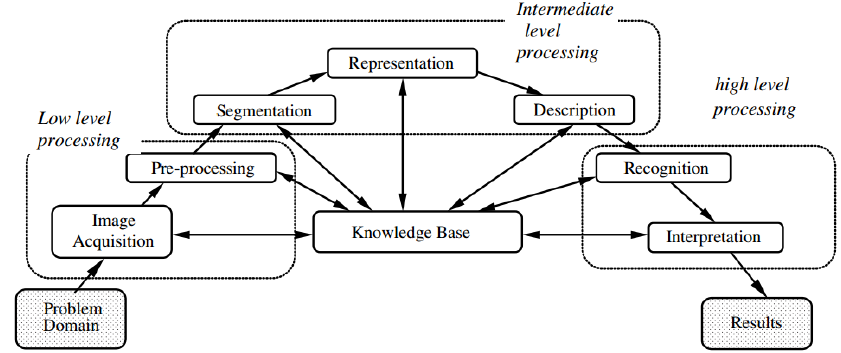
Figure 4. The three levels of image processing algorithm for external grading system process.